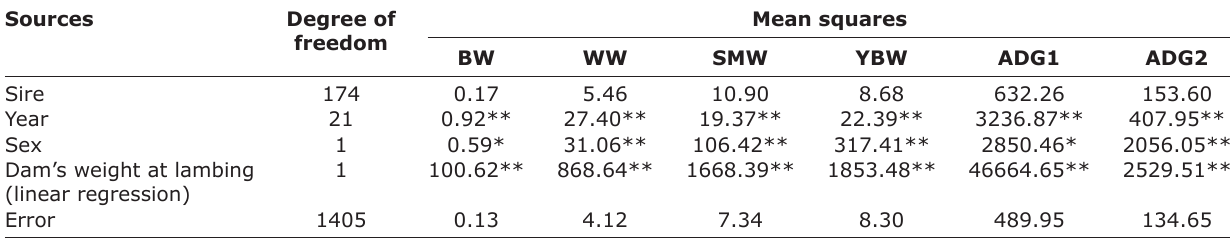
Table-1: Analysis of variance for growth traits.